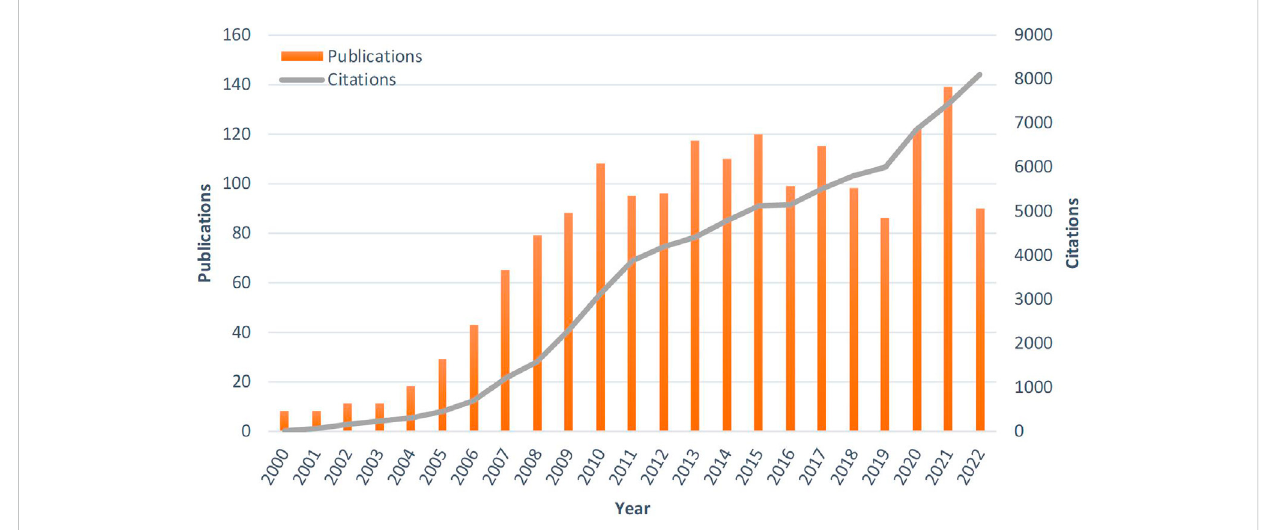
FIGURE 2 Trends of overall publications and citations on molecular imaging research in AS from 2000 to